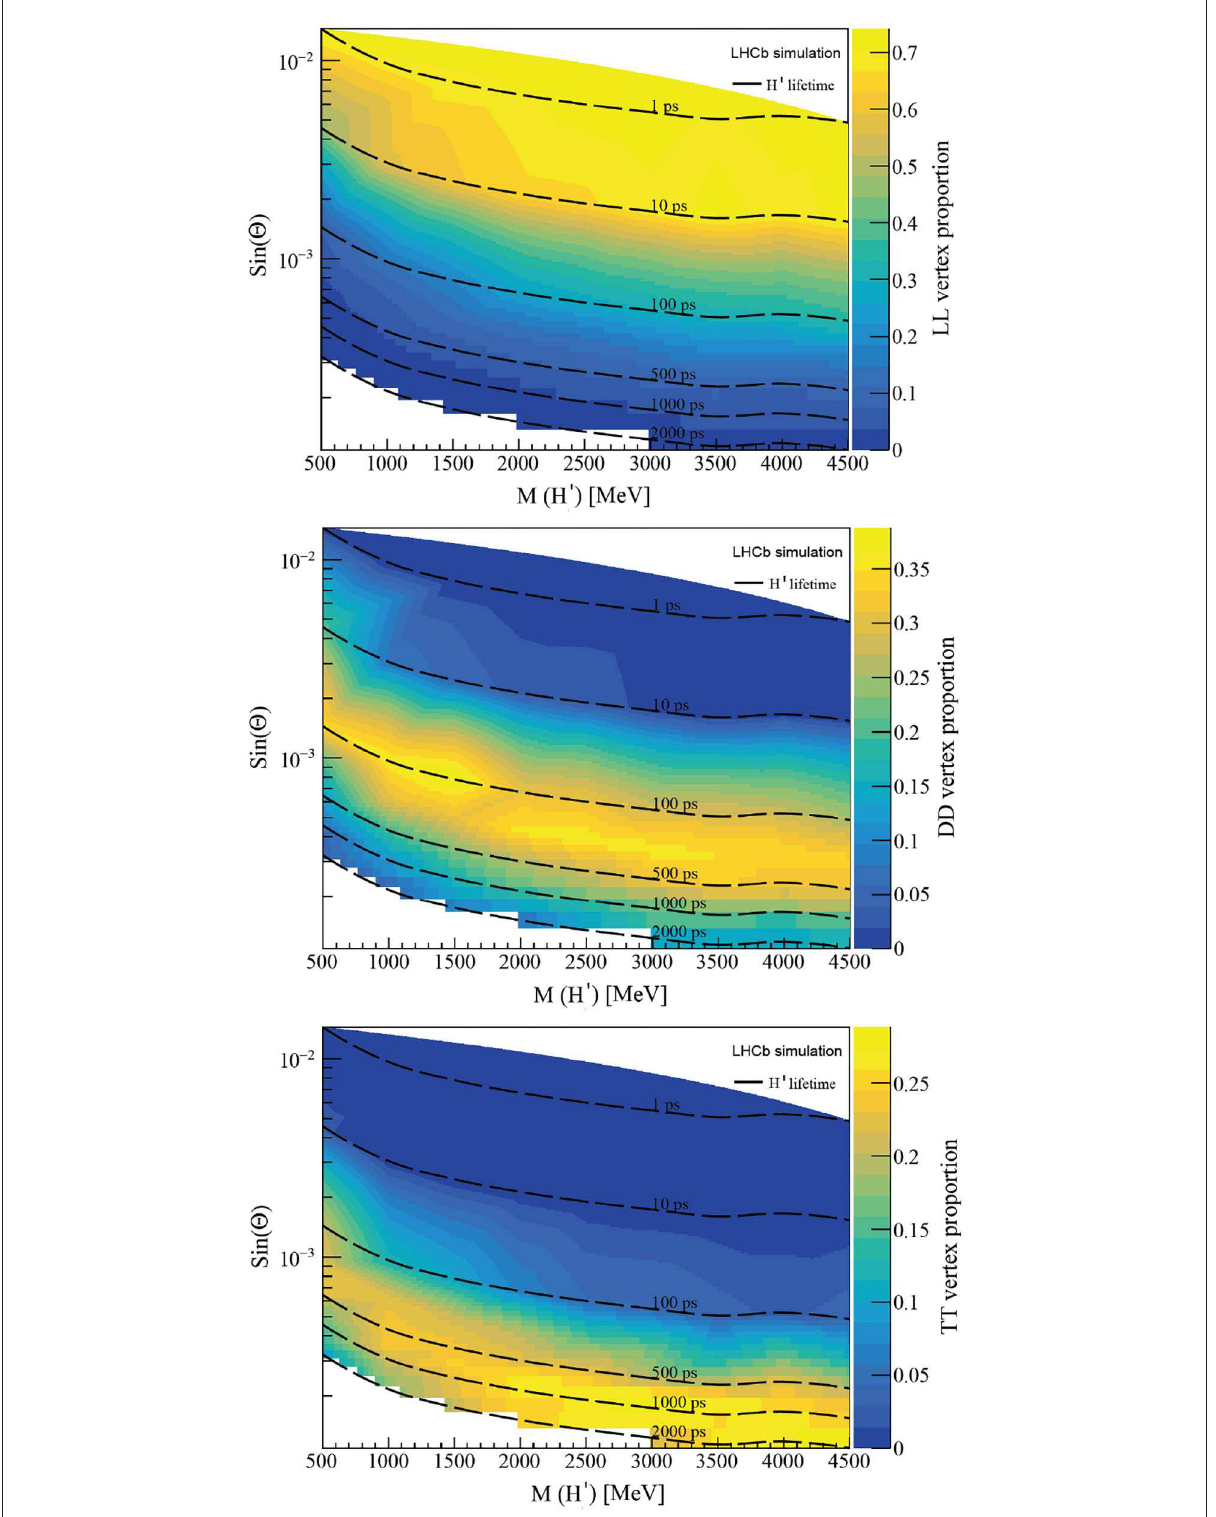
FIGURE9 Reconstructibility of the decay vertex of the H’ particle as a function of its mass and lifetime. Decay topologies are shown, from top to bottom, in the order: LL, DD, and TT, corresponding to the track types of the two